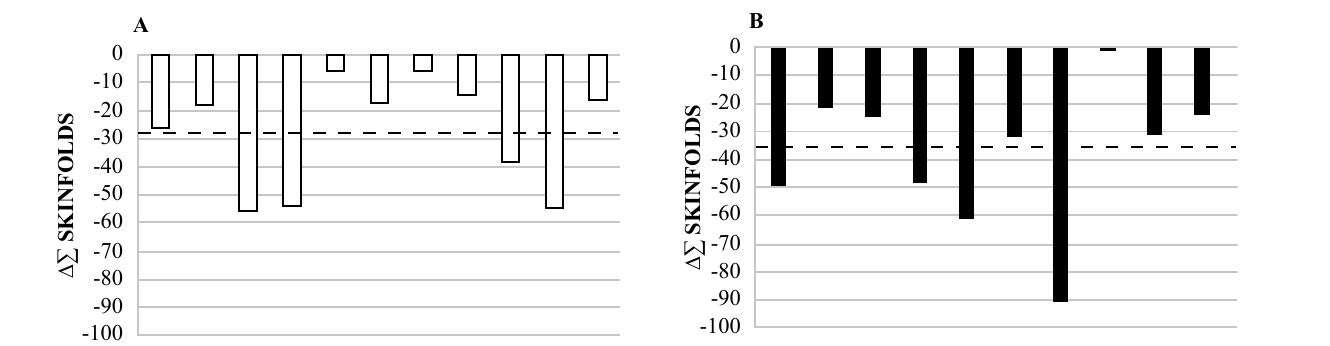
Figure 2 - Single subject analysis of aerobic training summation responses in ovulatory (OS) women (Figure 2A) and postmenopausal (MN) (Figure 2B). Data are individual descriptive values of the absolute magnitude of the reduction obtained with the